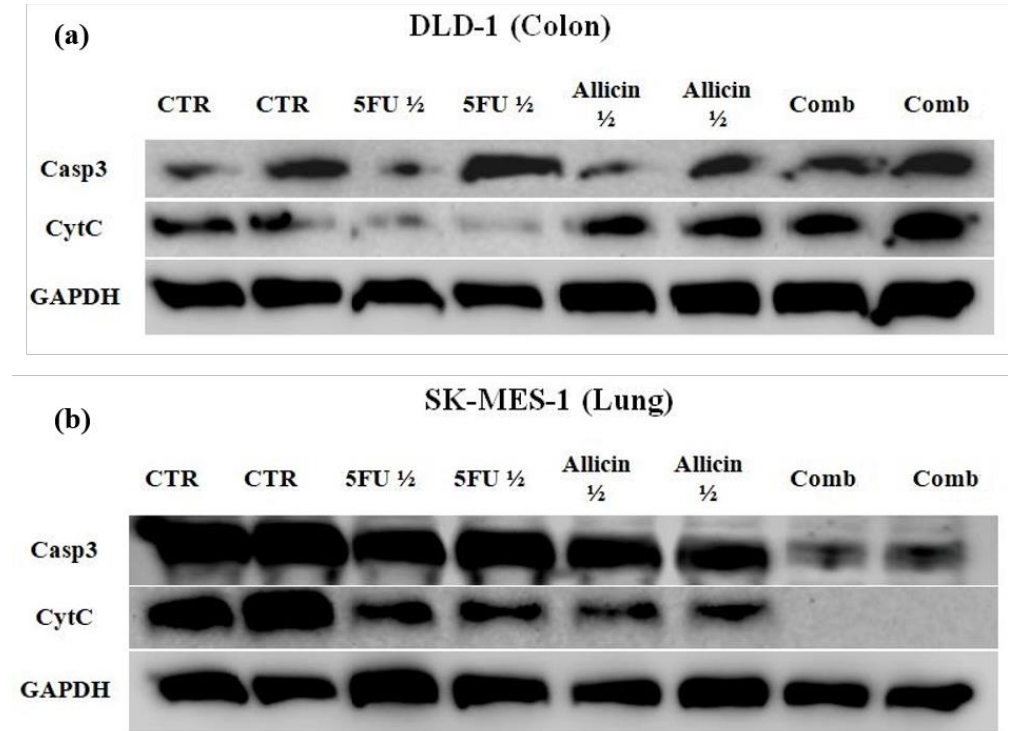
Figure 10. The western blot analysis of Caspase 3 and Cytochrome C in colorectal and lung cancer cells. ( a ) Western blot on DLD-1 cells, where GAPDH was used as the control and Caspase 3 and Cytochrome C were determined. ( b ) Western blot on SK-MES-1 cells, where the same molecules were determined as for DLD-1. Abbreviations: GAPDH, Glyceraldehyde 3-phosphate dehydrogenase; CytC, Cytochrome C; Casp3, Caspase 3; CTR, control; 5-FU half of the IC 50 , 5FU 1 / 2 ; allicin half of the IC 50 , Allicin 1 / 2 ; and “comb”, combination of the half IC 50 .